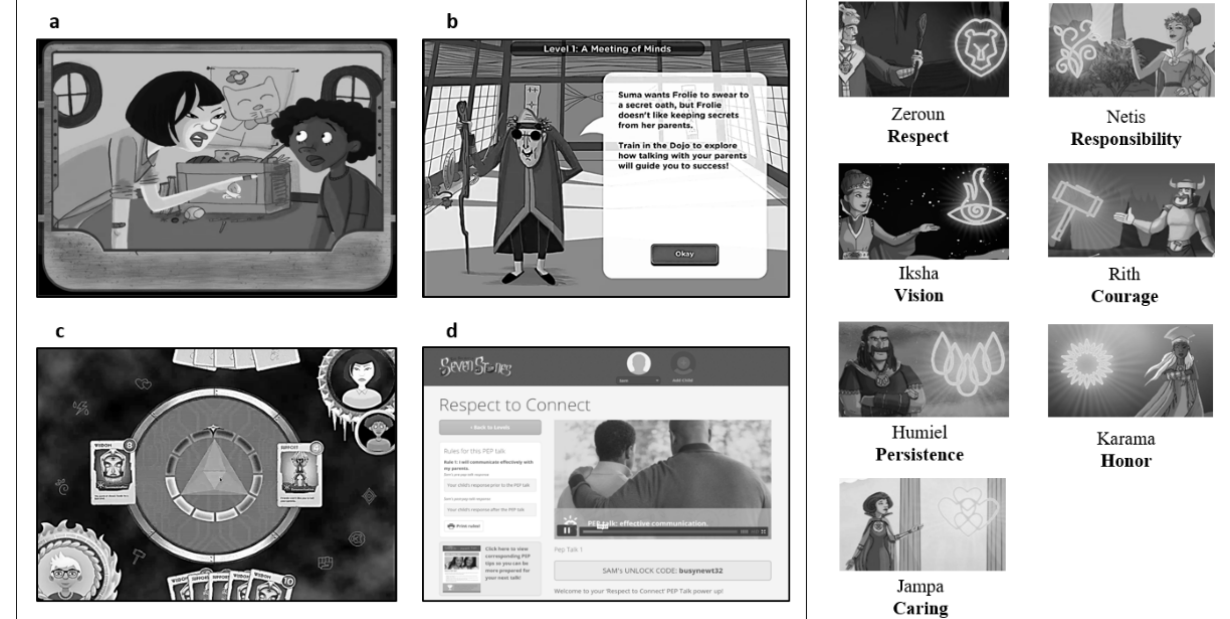
Figure 3. The Secret of Seven Stones (SSS) sample game and parent website screens and personified virtues. (a) Animated video introducing “Suma” and “Frollie” and the challenge scenario that requires resolution, (b) the “Dojo” (and Dojo master, Alfred) where the player receives skill training activities to prepare for “battle,” (c) card battle with wisdom, skill, and support cards to liberate Frollie, and (d) SSS parent website featuring parent resources (videos and tip sheets) to enable parent competency in partner-engage-plan talks, and an array (on right) of personification and imagery of virtues referred to in the